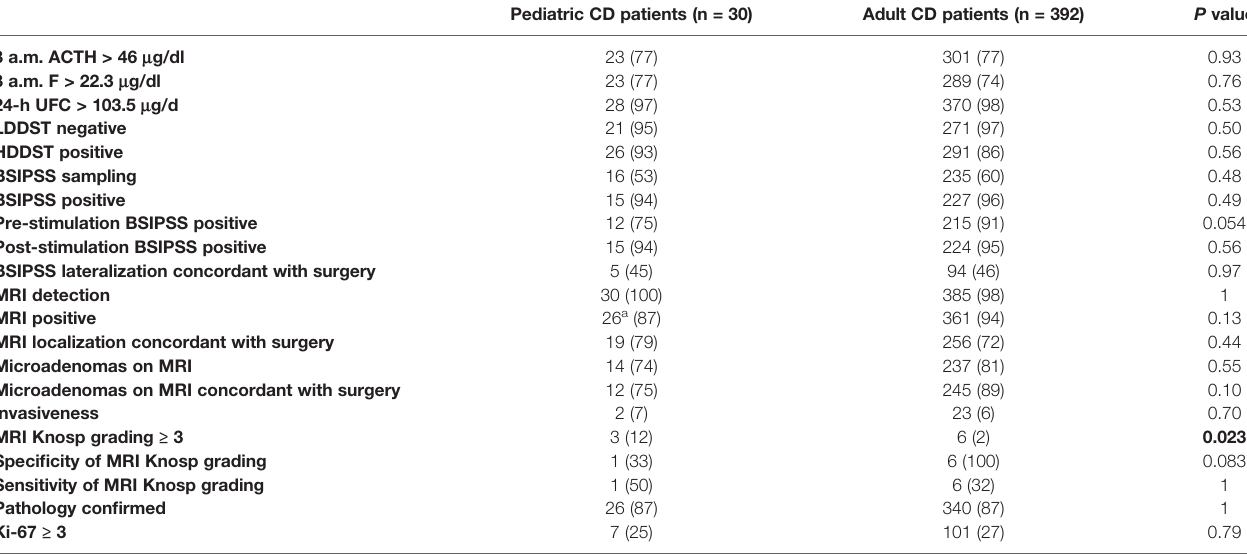
TABLE 2 | Clinical examinations of pediatric and adult-onset CD.